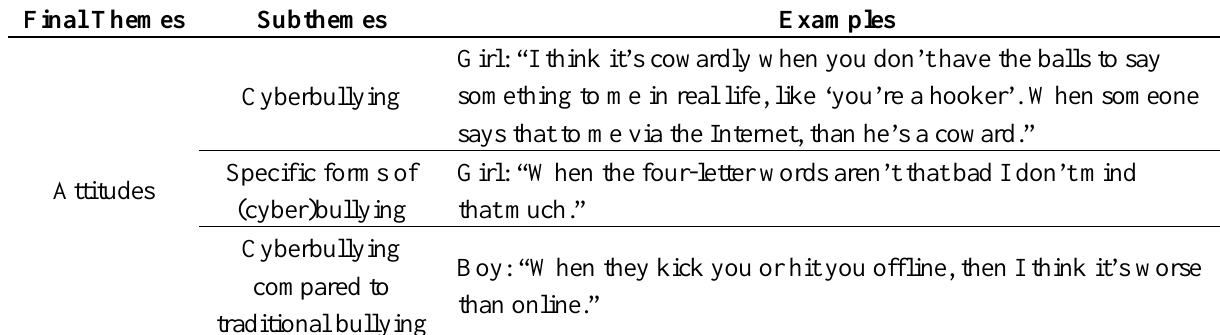
Table 7. Main themes, subthemes and examples of attitudes about